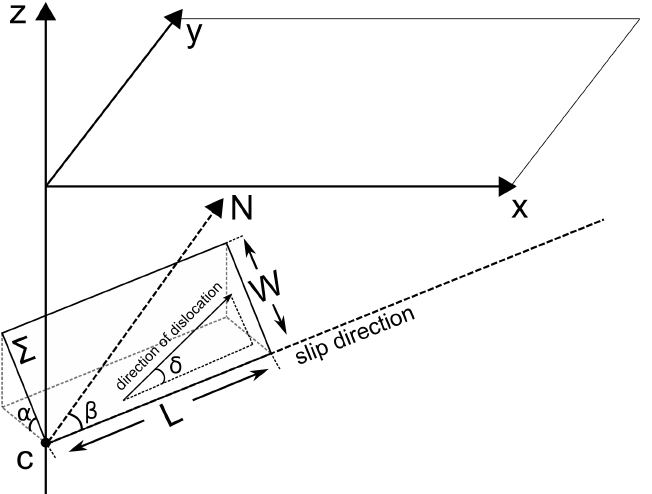
Figure 1. Schematic description of the earthquake source model. In the figure: α is the dip angle, β is the strike angle, δ is the angle of displacement direction, C is the hypocenter depth, L is the plane length, W is its width, N is the North direction (the axis is aligned with OY ), and Σ is the fault plane with an equivalent distributed system of double forces with a